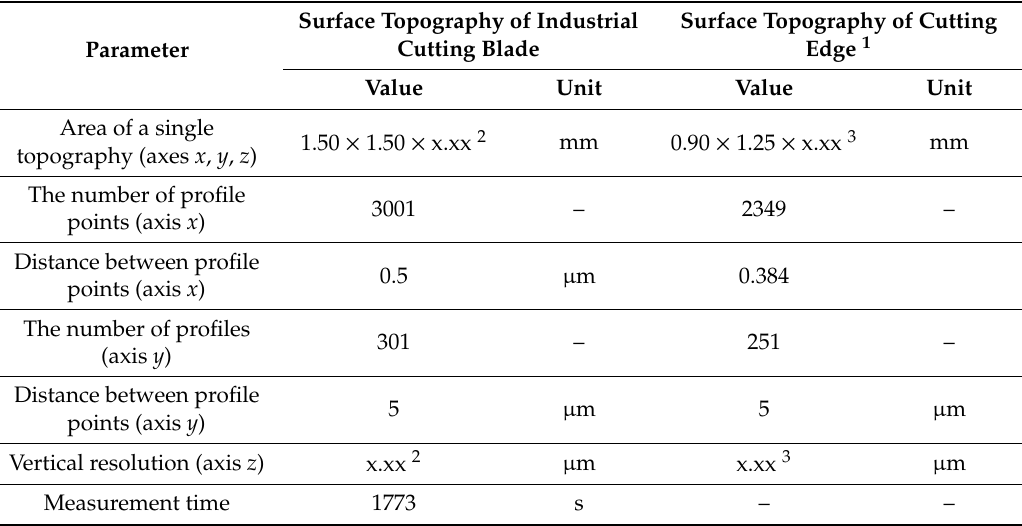
Table 5. General characteristics of measurement conditions.